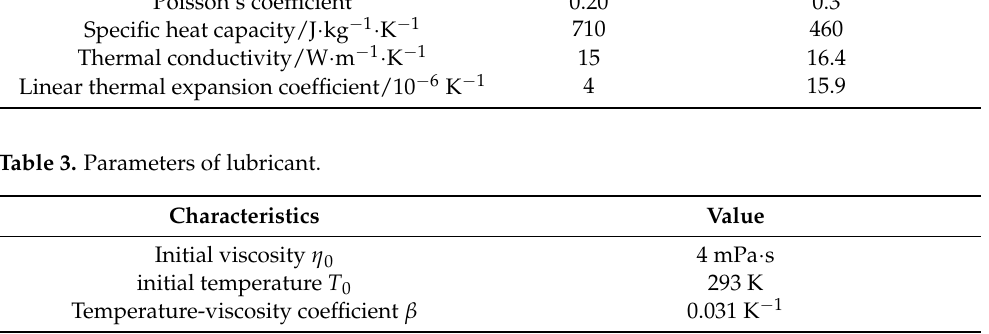
Table 2. Characteristics of the materials.